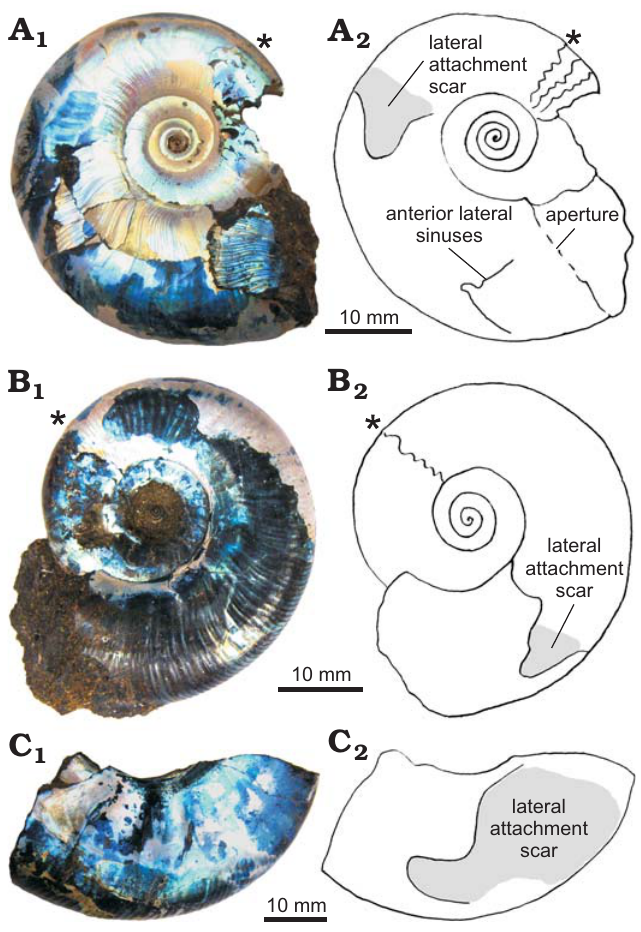
Fig. 5. Lateral attachment structures on Kachpurites cheremkhensis Mitta, Michailova, and Sumin 1999 shells from Late Volgian ( Kachpurites fulgens Zone), Yaroslavl region, Cheremukha locality. A . MSU 113/3, whole shell with a scar at the middle section of the body chamber and a lateral sinus, which is located ventro-laterally not far from the aperture. B . MSU 113/10, shell with the apertural part of the body chamber not preserved, the scars are slightly asymmetric. C . MSU 113/36, fragment of the body chamber of ribbed macroconch, with scars on both sides of the shell. The scar demon- strate ventro-lateral projection on its front part. Asterisks mark the base of the body chamber. Photographs (A –C ) and explanatory drawings (A –C ). 1 1 2 2